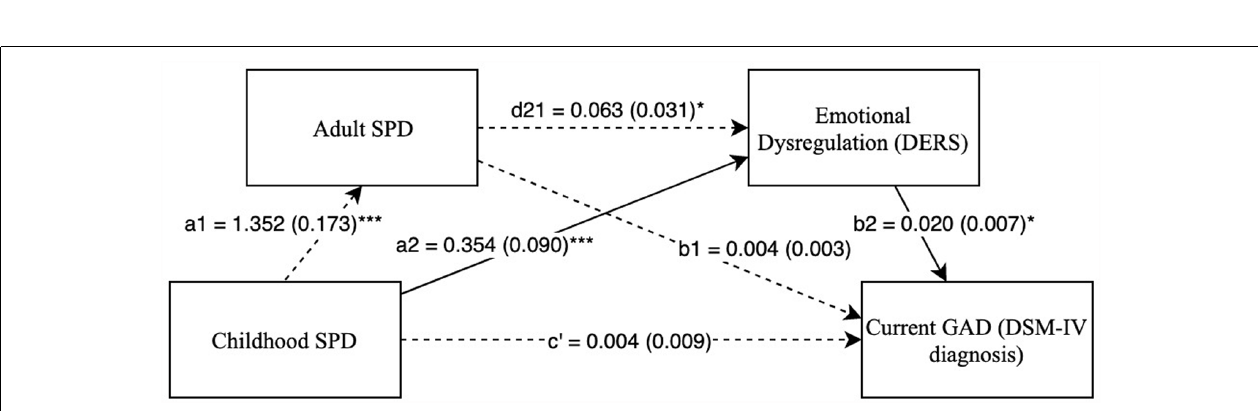
FIGURE 4 | Childhood SPD predicting current GAD with adult SPD as mediator 1 and emotional dysregulation as mediator 2. Note: ∗ p < 0.05, ∗∗∗ p < 0.001. Standard errors are in parentheses, solid lines represent significant indirect paths, a1 = unstandardized regression coefficient for the IV predicting the mediator 1, a2 = unstandardized coefficient for the IV predicting mediator 2 with mediator 1 in the model, d21 = unstandardized regression coefficient for mediator 1 predicting mediator 2 with IV in the model, b1 = unstandardized regression coefficient for mediator 1 predicting the DV with IV and mediator 1 in the model, b2 = unstandardized regression coefficient for mediator 2 predicting the DV with mediator 1 and the IV in the model, c (cid:48) = unstandardized coefficient for the IV predicting the DV with both the mediators in the model (indirect effect). SPD, Sensory Processing Disorder symptoms; DERS, Total score on Difficulty in Emotion Regulation Scale; SPDI, Sensory Processing Disorder Interview, version 2. Sex and race are included as covariates in all regression equations, coefficients of covariates are omitted for